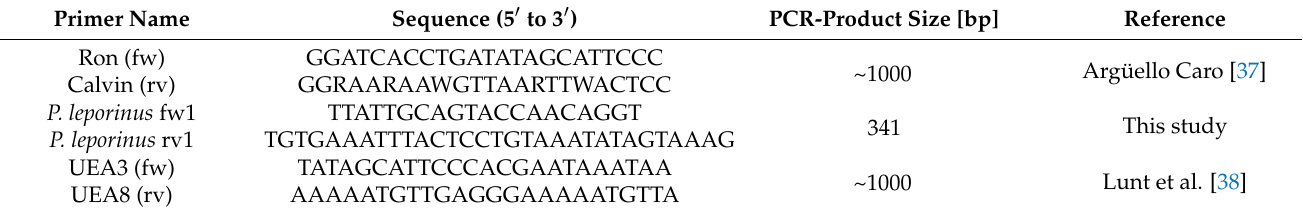
Table 1. List of primers used for partial amplification of mitochondrial cytochrome oxidase I gene ( COI ) from Pentastiridius leporinus , Reptalus quinquecostatus and Hyalesthes obsoletus